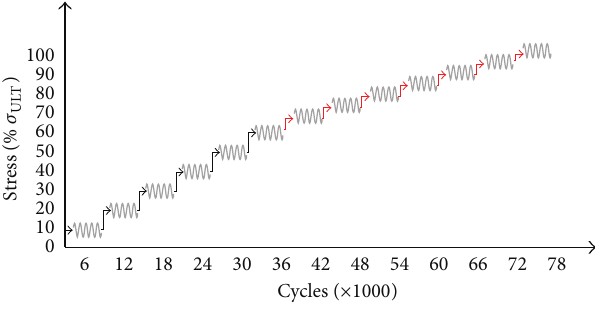
Figure 2: Schematic of fatigue loading